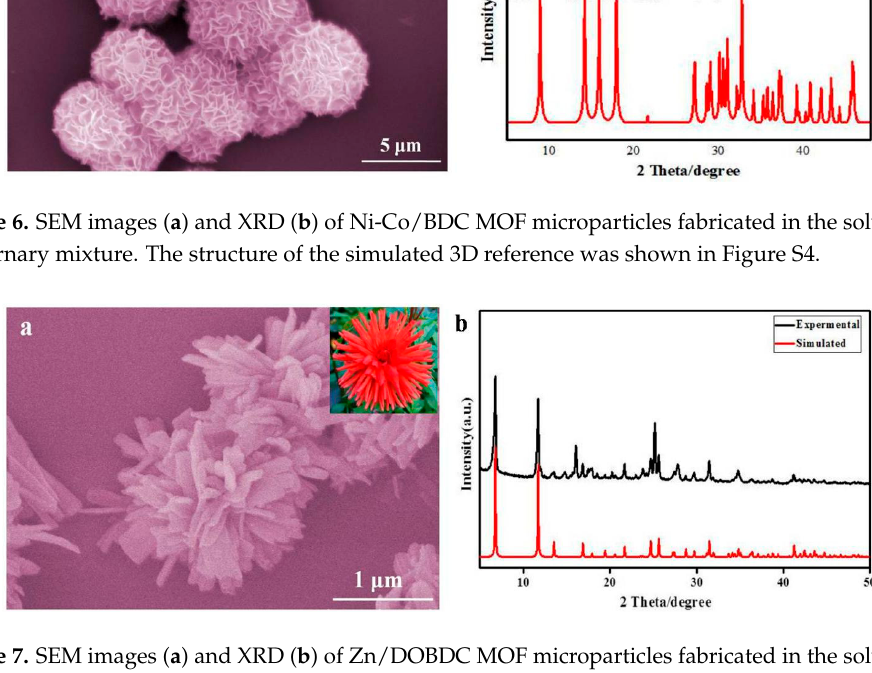
Figure 7. SEM images ( a ) and XRD ( b ) of Zn/DOBDC MOF microparticles fabricated in the solvent of the ternary mixture. The structure of the simulated 3D reference was shown in Figure S5. The insert in ( a ) is a natural chrysanthemum.